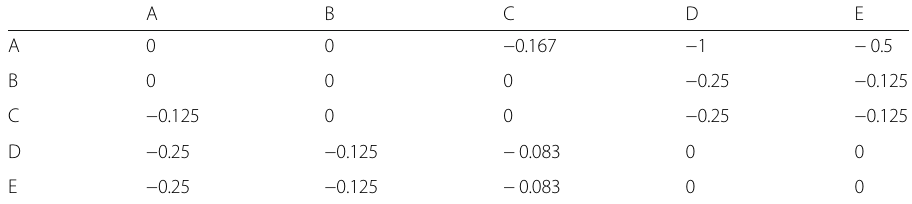
Table 2 Negative effect of one node on another up to 2 steps for the toy network shown in Fig. 1. Each cell records the negative effect from one node in a particular row on another node in a